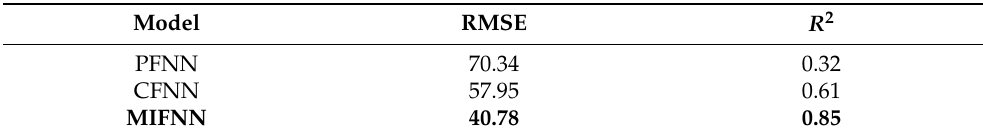
Table 3. Performance comparison of PFNN, CFNN, and MIFNN models.